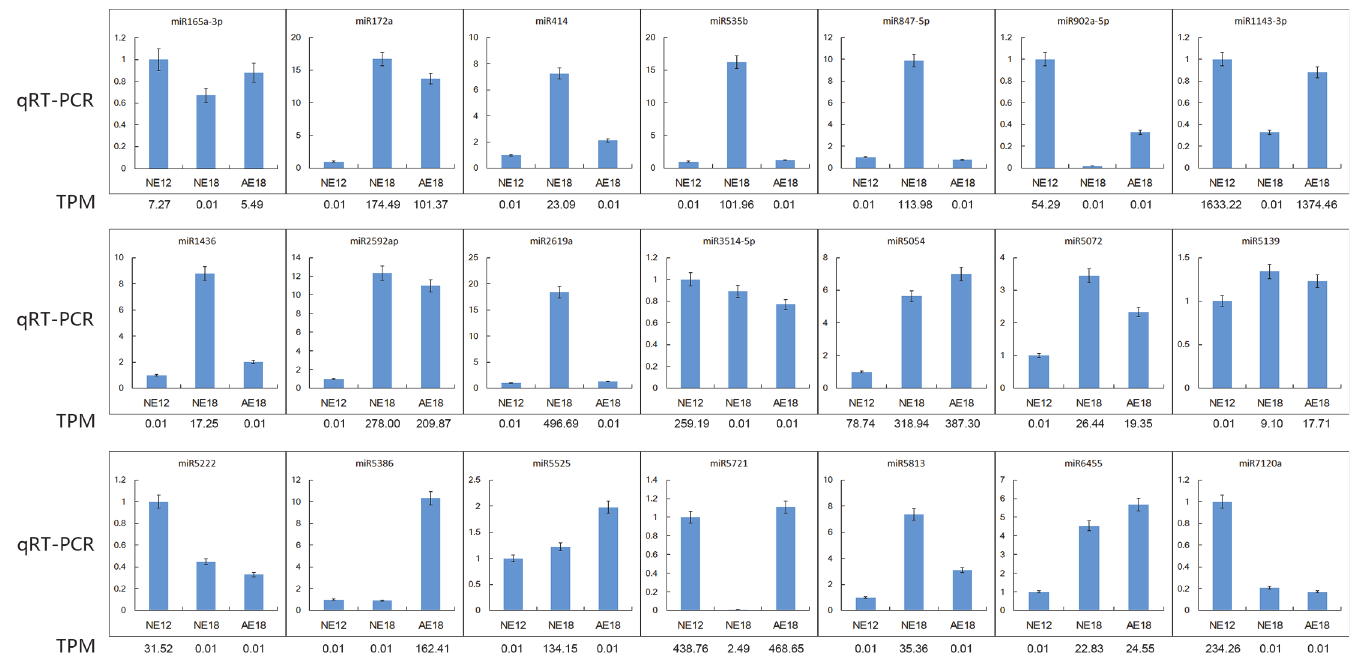
Fig 4. Validation of 21 known miRNAs by qRT-PCR. TPM is their abundance in the sequencing data of the sRNA libraries.